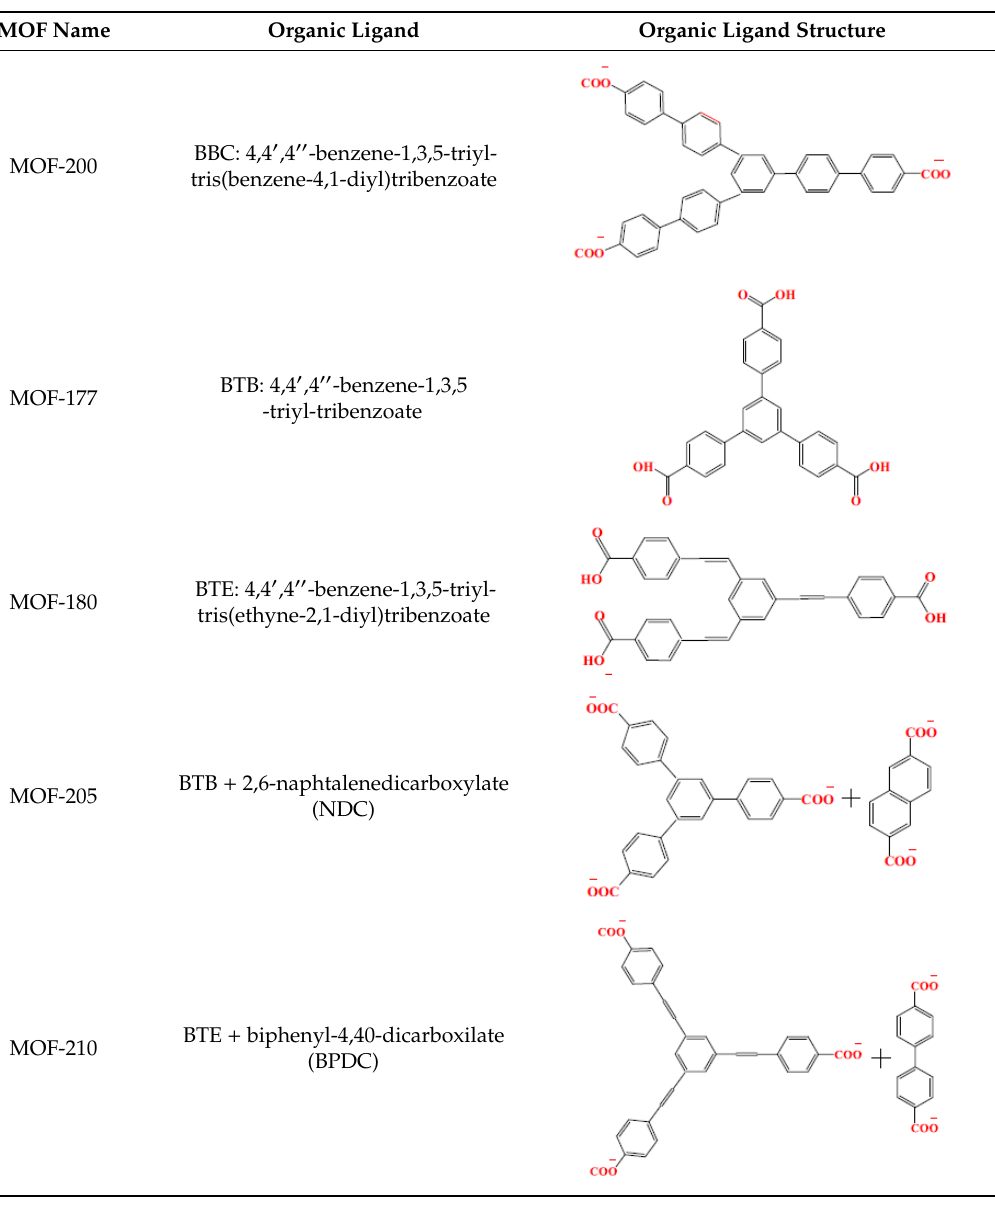
Table 2. Chemical formulas and chemical structures of some organic ligands in some frequently used MOFs [15].